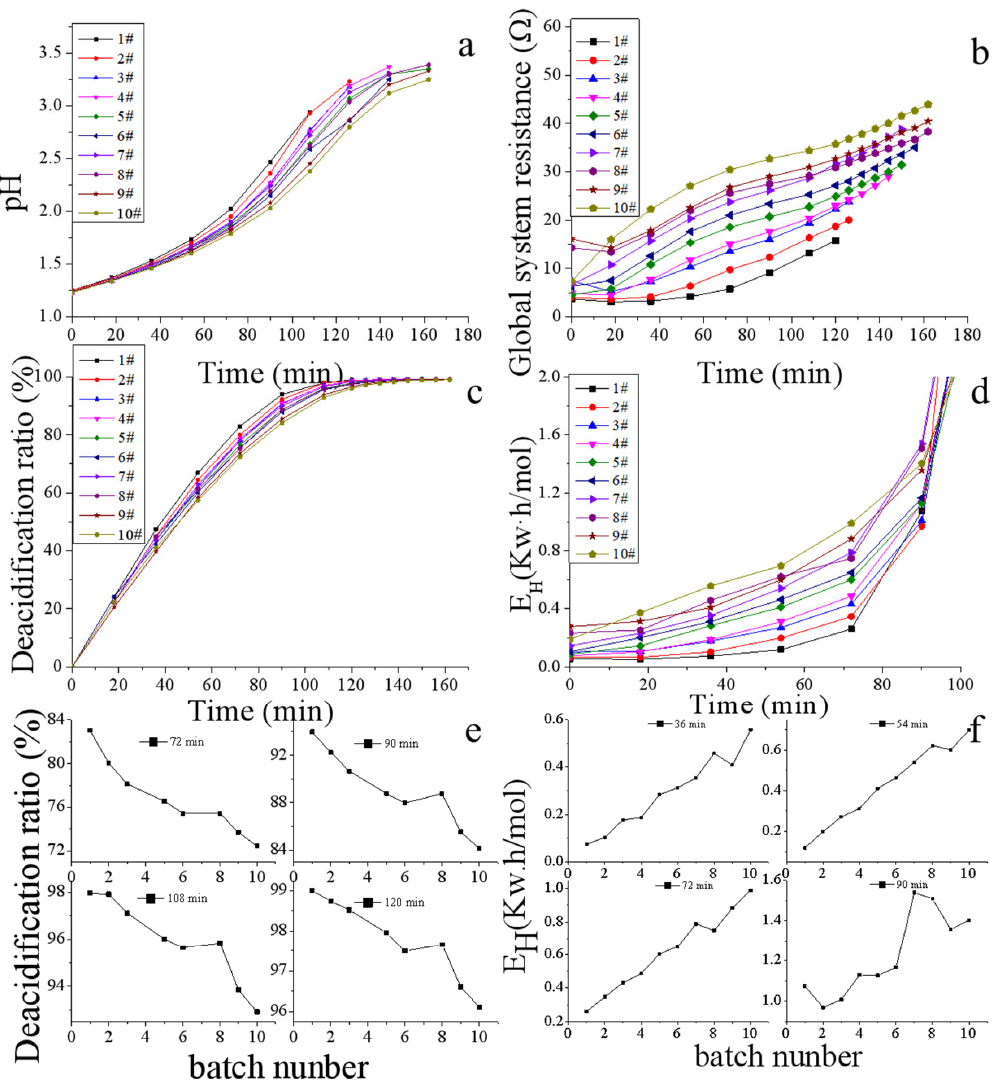
Figure 2. Evaluation parameters of ED system during the electrochemical deacidification of CAH. ( a ) pH, ( b ) global system resistance, ( c ) deacidification ratio, ( d ) H + relative energy consumption, ( e ) instantaneous deacidification rate, ( f ) instantaneous H + relative energy consumption.